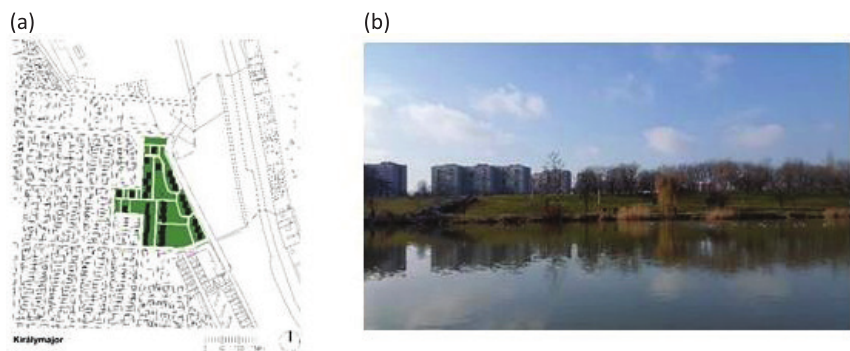
Figure 5. Királymajor HE: (a) Layout and (b) location on the riverbank of the Danube.